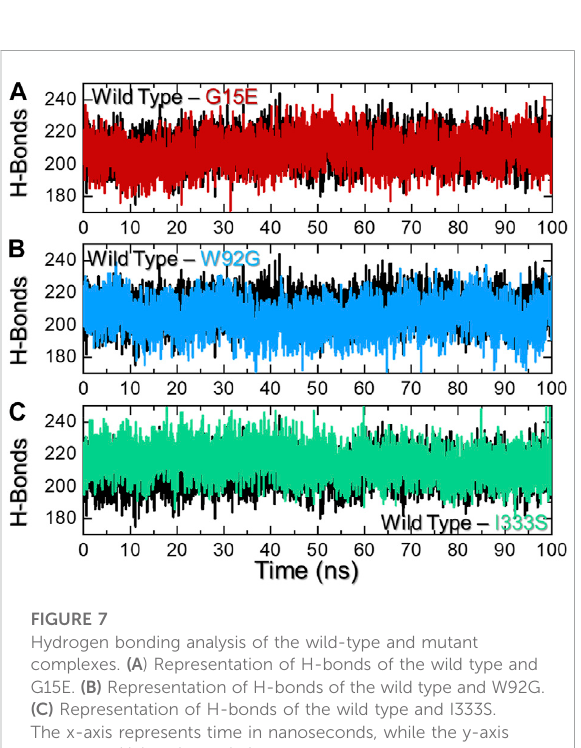
FIGURE 7 Hydrogen bonding analysis of the wild-type and mutant complexes. (A ) Representation of H-bonds of the wild type and G15E. (B) Representation of H-bonds of the wild type and W92G. (C) Representation of H-bonds of the wild type and I333S. The x-axis represents time in nanoseconds, while the y-axis represents H-bond